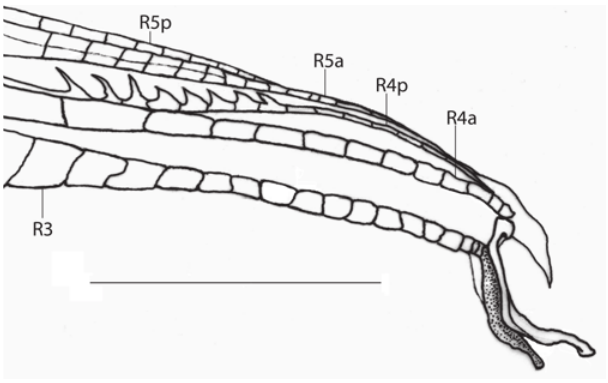
Fig. 9. Gonopodium tip of Phalloceros heptaktinos , MCP 19831. R3, R4a, R4p, R5a, R5p indicate gonopodial rays. Scale bar 1 mm. Table 4. Descriptive morphometrics of male specimens of Phalloceros heptaktinos , P . malabarbai , P . buckupi , and P . lucenorum . Measurements 1-10 are percents of standard length and measurements 11-13 are percents of head length. H = holotype.